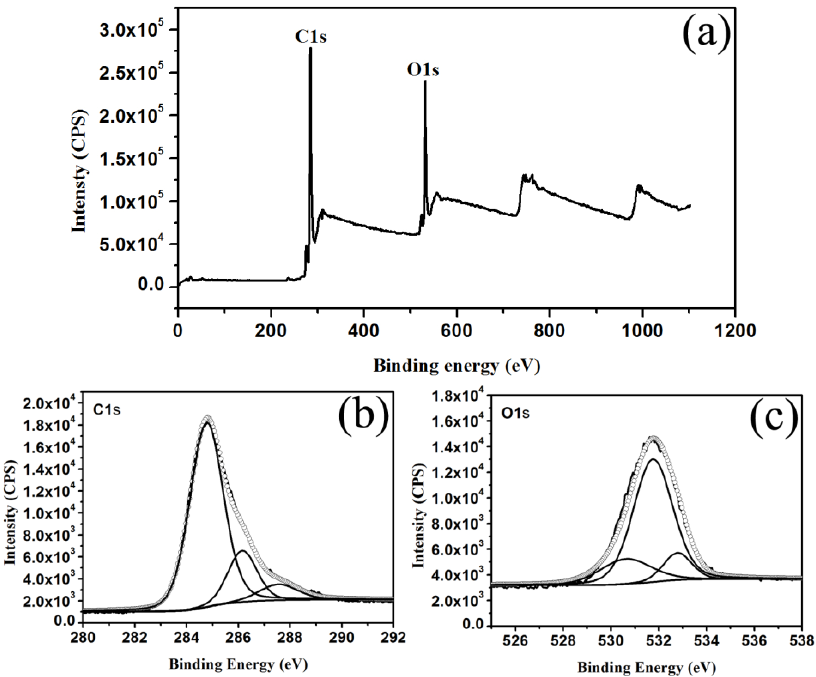
Figure 3. ( a ) X ‐ ray photo ‐ electron spectroscopy (XPS); ( b ) C 1s ; and ( c ) O 1s spectra of the as ‐ prepared